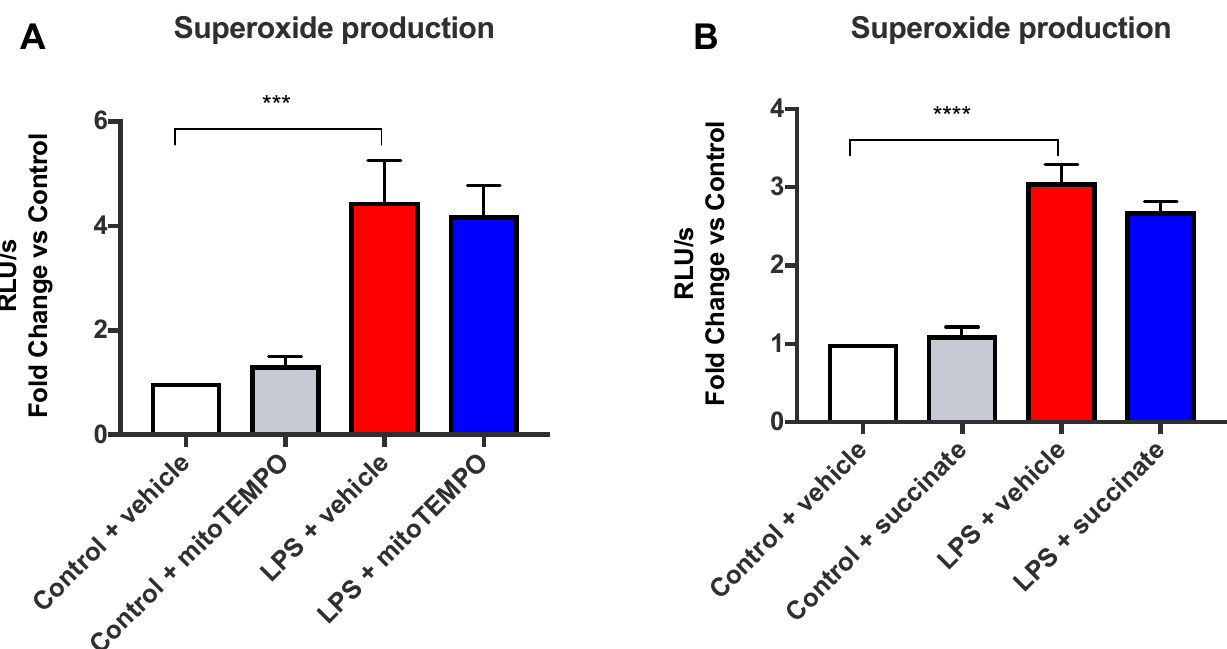
Figure 2. Mitochondrial activity has no effect on the NOX2 oxidase-dependent oxidative burst in macrophages. Oxidative burst measured by L-012-enhanced chemiluminescence in RAW 264.7 cells pre-treated with ( A ) MitoTEMPO (1 mM) for 1 h, or ( B ) succinate (5 mM) for 3 h, followed by LPS (100 ng/mL) stimulation for 24 h. Data are presented as mean ± SEM of n = 8–9 experiments. Data are expressed as a fold change against the respective control in relative light units (RLUs), measured as an average of triplicates over a 60-cycle period, subtracted by blank readings. Statistical analysis was conducted via a one-way ANOVA followed by Tukey’s post hoc test for multiple comparisons. *** indicates p < 0.001 and **** indicates p < 0.0001 against control.